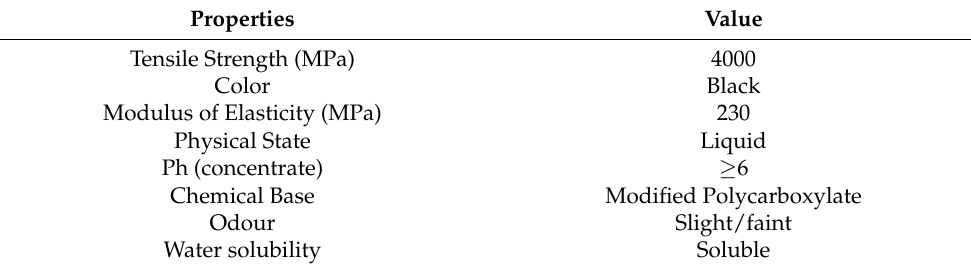
Table 6. Physical and chemical properties of